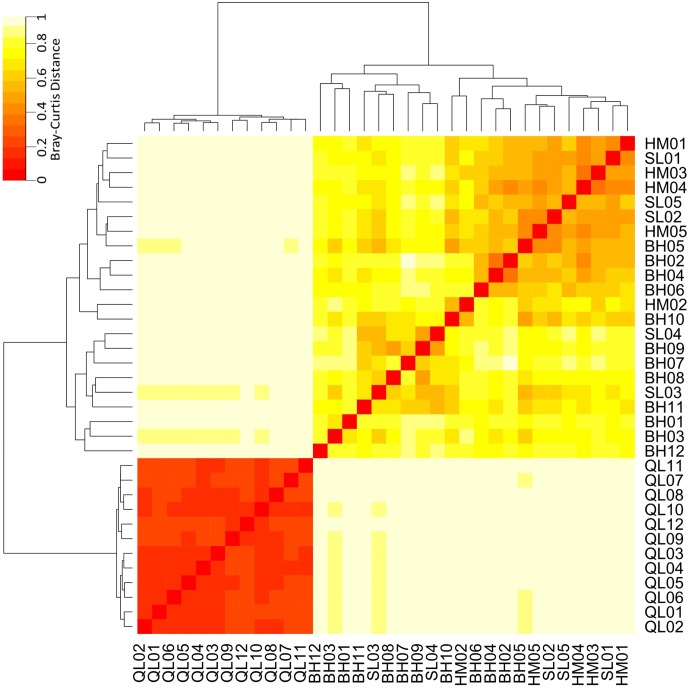
Heatmap showing the taxonomic differences of microbial communities between streams and Qinghai Lake based on Bray–Curtis distance. Bray–Curtis distances were calculated using relative abundances of OTUs.